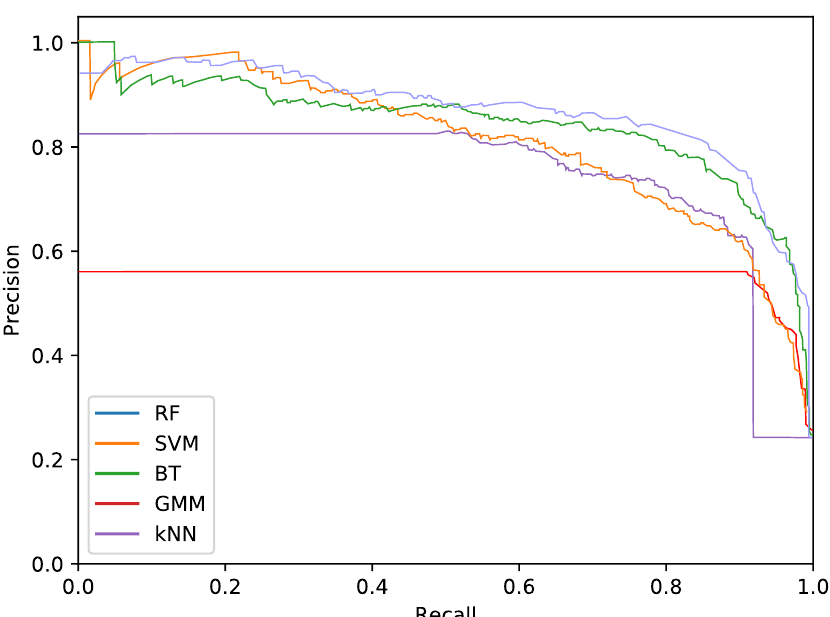
Figure 6. Precision-recall curve for the best performing classifiers using only colour features.